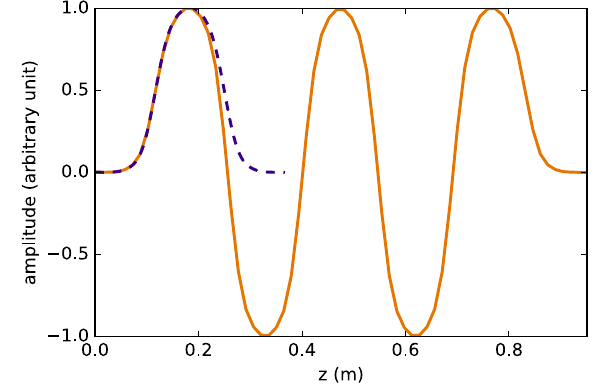
FIG. 16. Field profile of rf cavity. Orange line represents the 5 cell rf cavity used for Project-X. Blue dashed line represents the single cell bunching cavity. one is used for splitting the two different beam energies. The second arc for the reentry to the LINAC also consists of five bending magnets where the bending angle of the last one is negative for merging the two different beam